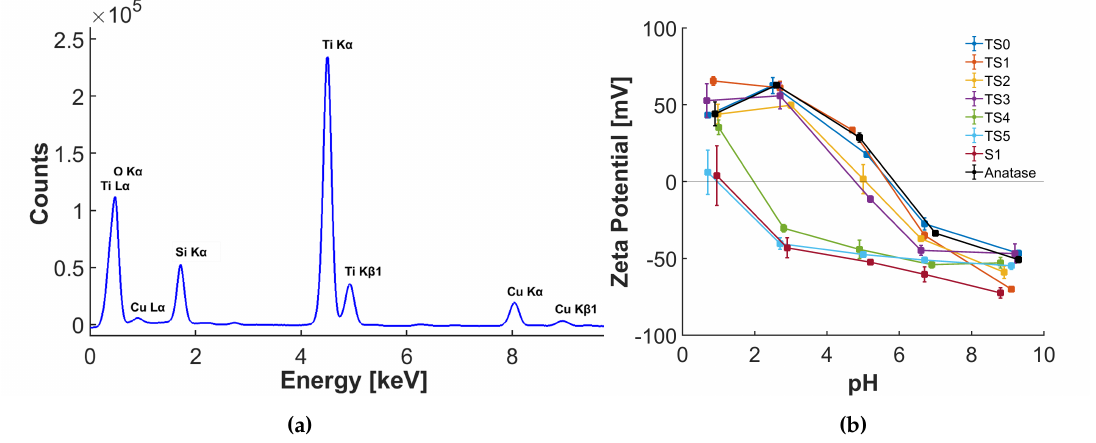
Figure 2. ( a ) Energy-dispersive X-ray spectrum (EDX) of the TS4 sample. ( b ) Variations of zeta potentials with pH of reference anatase, synthesised silica, and core-shell samples with various step